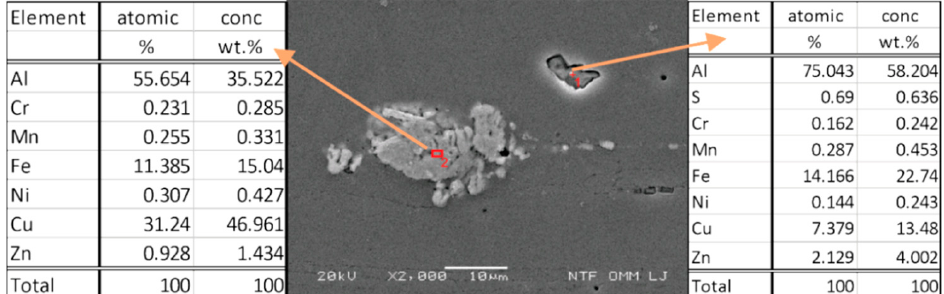
Figure 9. SEM image and chemical analysis of precipitates.